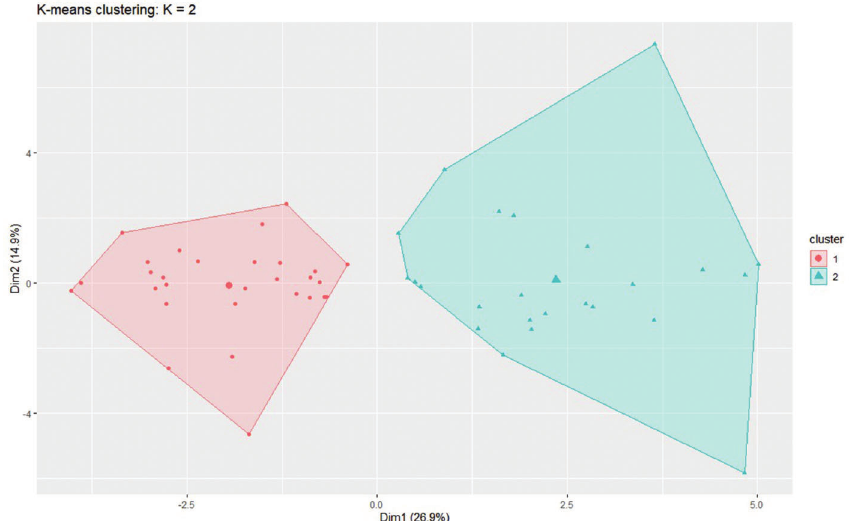
Figure 1 - Cluster analysis of COVID-19 survivors with the K-Means